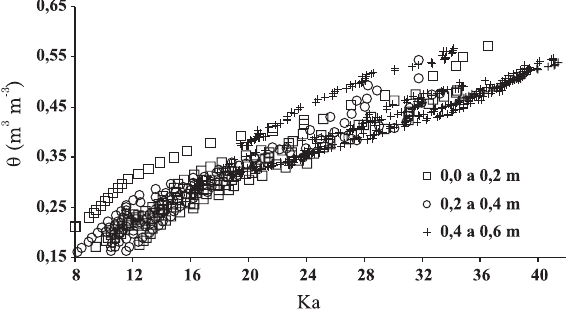
Figura 1. Valores de umidade do solo com base em volume, θθθθθ , e de kA, em diferentes valores de densidade do solo, obtidos nas três camadas de solo estudadas.